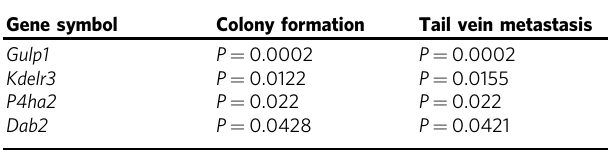
Table 1 siRNA screen for metastatic potential of four putative MetDev